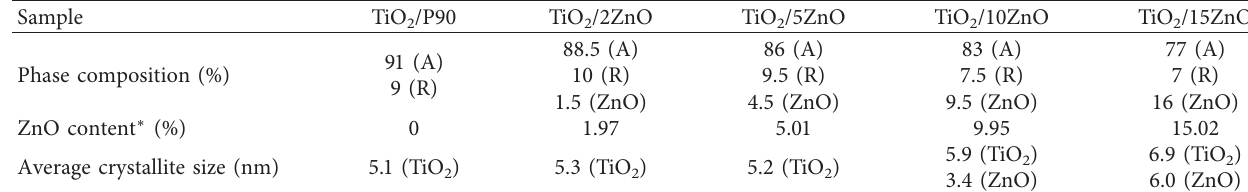
Table 1: Diffraction analysis data and ZnO content in